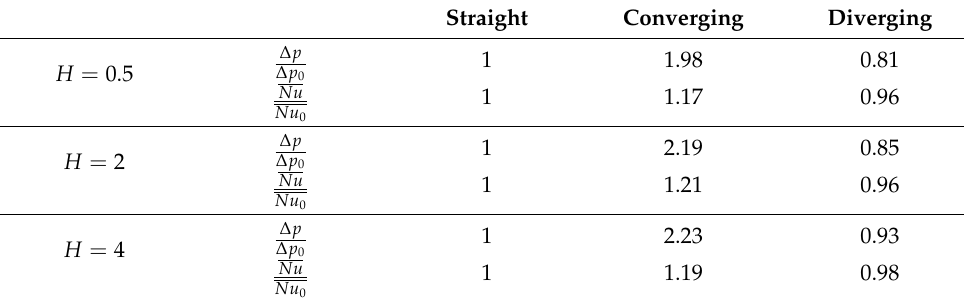
Table 4. System performance comparison at H = 0.5,2, and 4